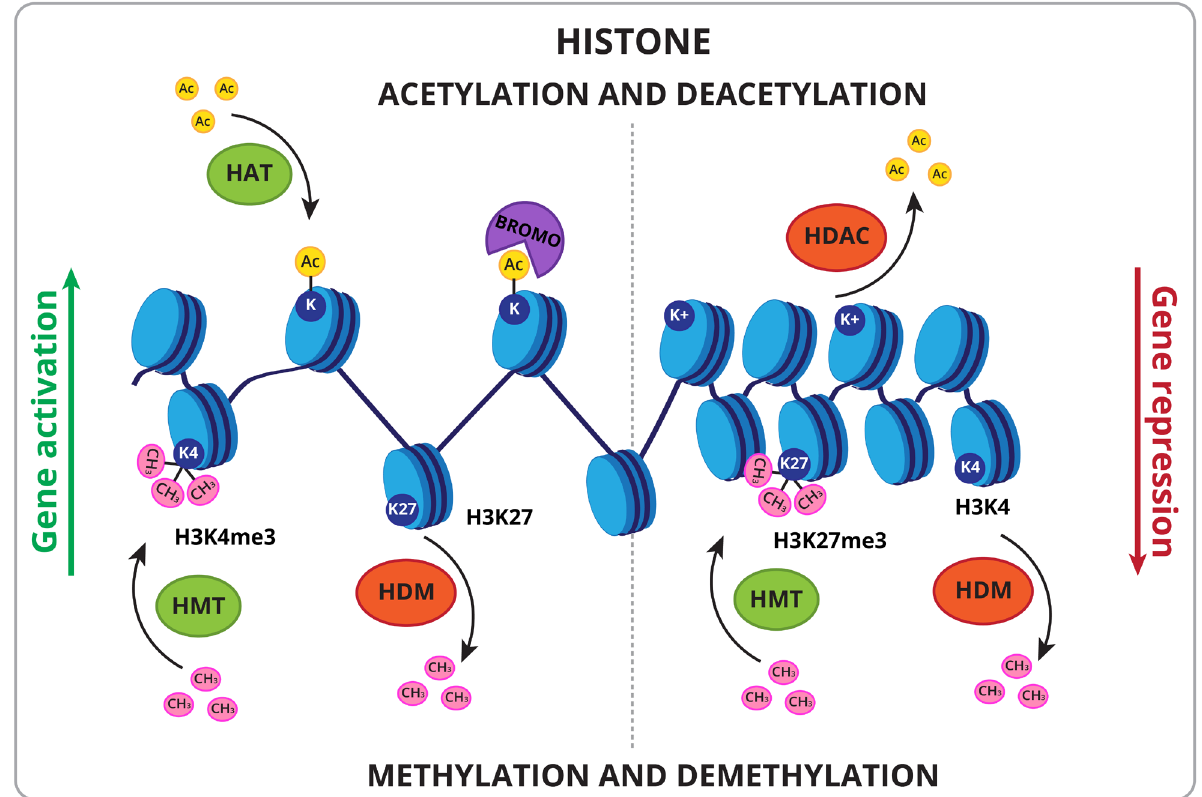
Figure 1 – Histone epigenetic marks. Histone modifications associated with gene activation (left) and with gene repression (right). Histone acetylation involves histone acetyltransferase (HAT) that mediates the ligation of acetyl groups (Ac) to lysine residues (K + ) of histones that form the nucleosome (light-blue circles), and as a result an open configuration of the chromatin. Readers as Bromodomain proteins (BROMO) are needed to mediate downstream biological responses. Histone deacetylation involves histone deacetylases (HDAC) to remove acetyl groups of histones (Ac) increasing their affinity to DNA and a close configuration of the chromatin. Histone methylation and demethylation occur through the activity of histone methyl transferases (HMT) and demethylases (HDM), respectively. Tri-methylation of the fourth lysine of histone 3 (H3K4me3) and demethylation of lysine 27 of histone 3 (H3K27) results in gene activation, whereas trimethylation of lysine 27 of histone 3 (H3K27me3) and demethylation of the fourth lysine of histone 3 (H3K4) results in gene